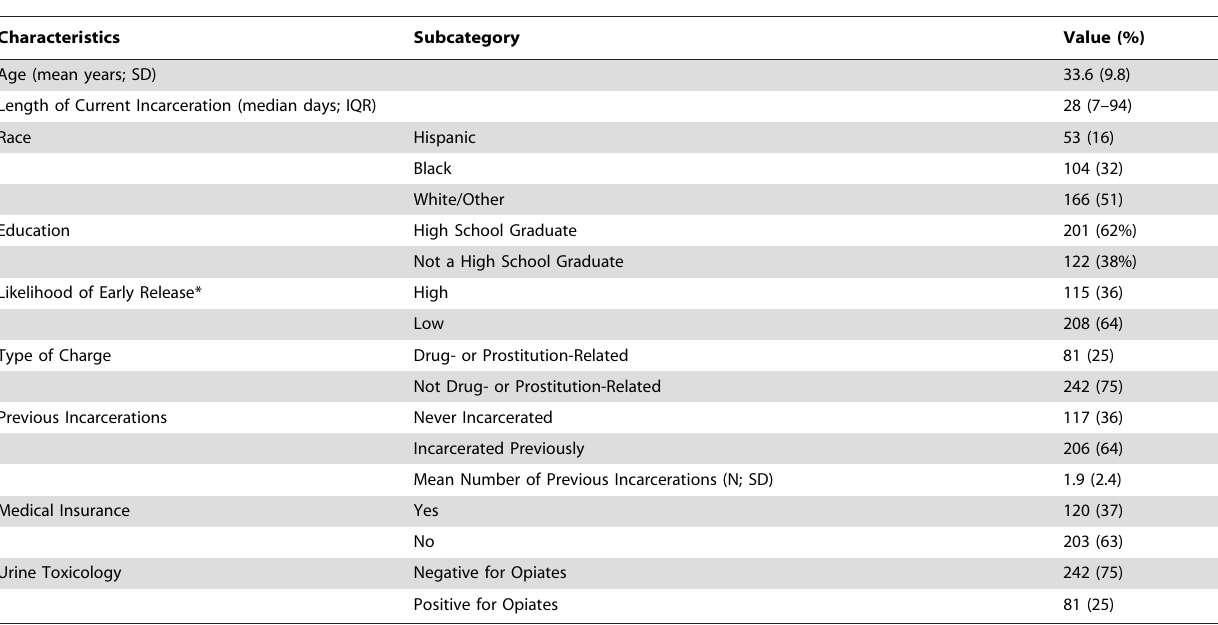
Table 1. Baseline Characteristics of the Study Population (n